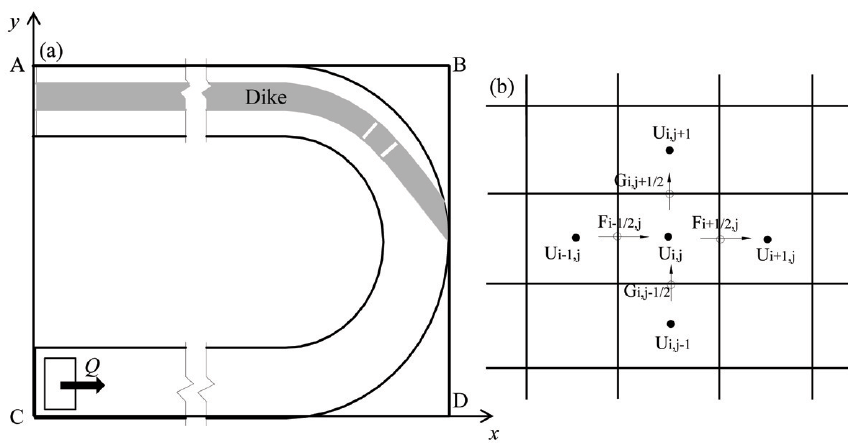
Figure 13. Calculated